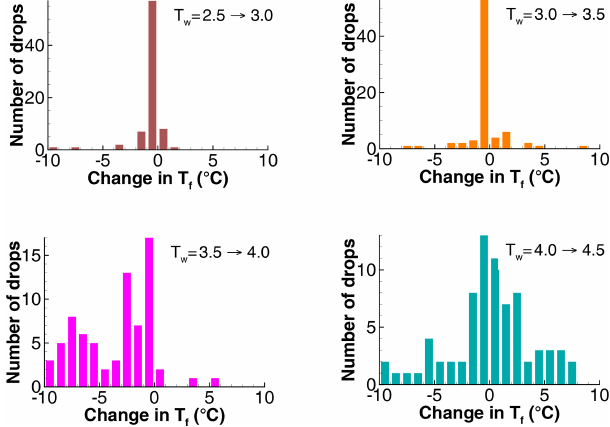
Figure 9. Spiderweb diagram of individual drop histories for the sequence of runs with increasing warm limits in Exp. A. A statistical representation of these observations is given in Fig. 3.